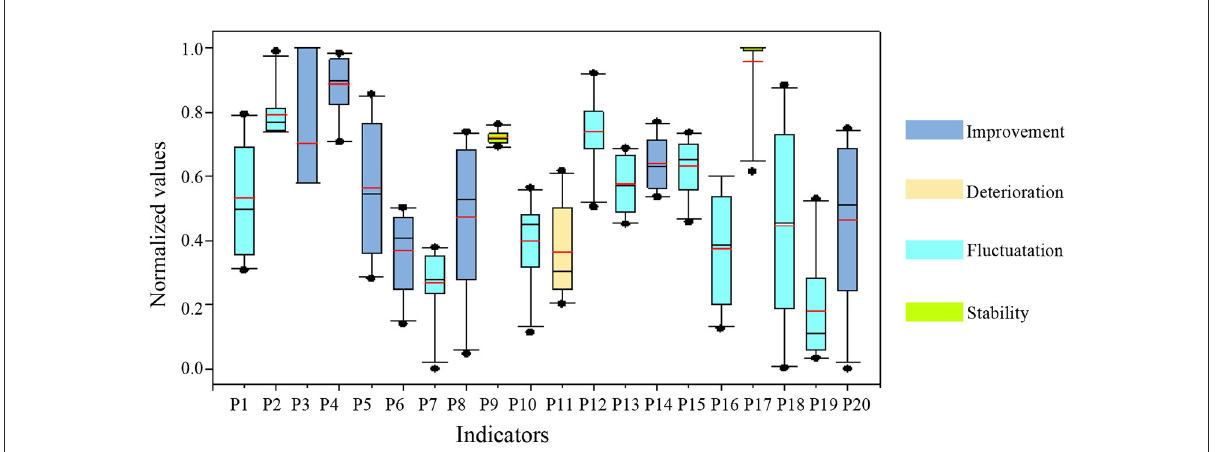
FIGURE5 The quartiles map and trend of indicators (red line represents the mean of the indicators, and colors indicate the type of an indicator changing over